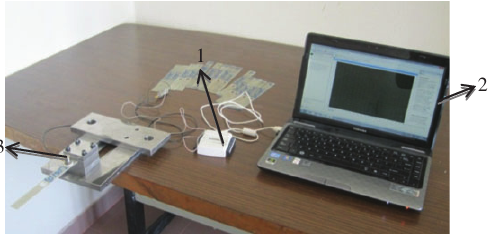
Figure 2 Laminated glass-polyester composite plates.